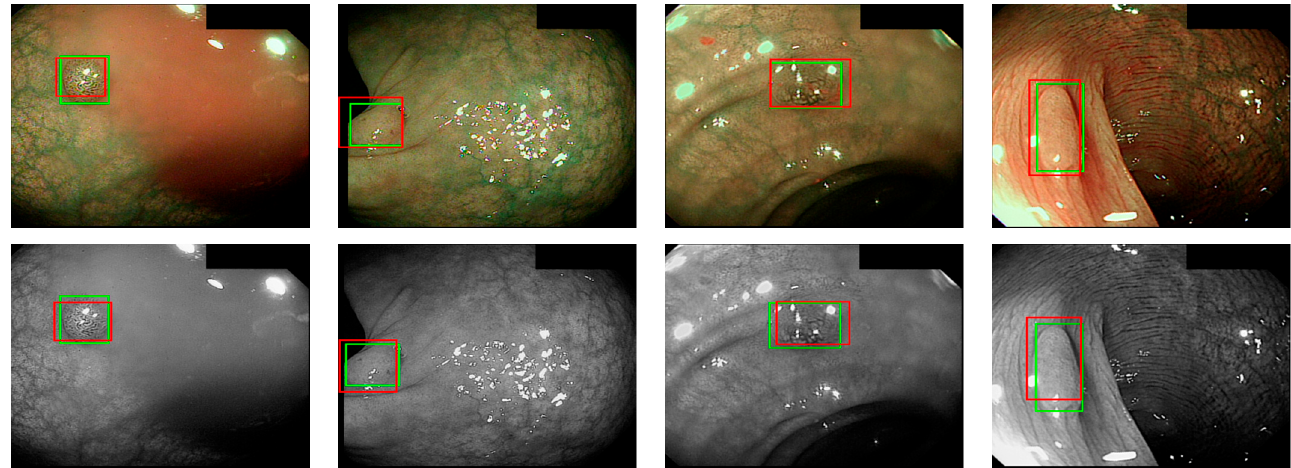
Figure 10. WL polyp detection.